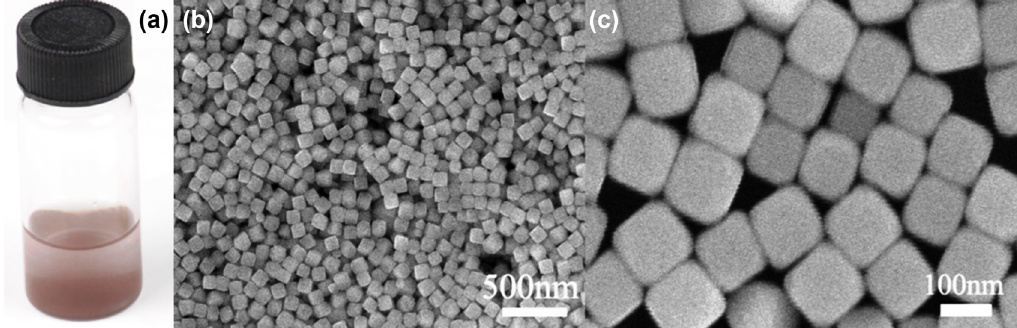
Figure 7: Figure 7 show the ( a ) colloidal solution of copper nanocubes and the TEM images ( b – c ) of well - de fi ned copper nanocubes using the solution - phase reduction technique with ascorbic acid is used as a reducer and PVP as the capping agent [ 142 ] . Copyright